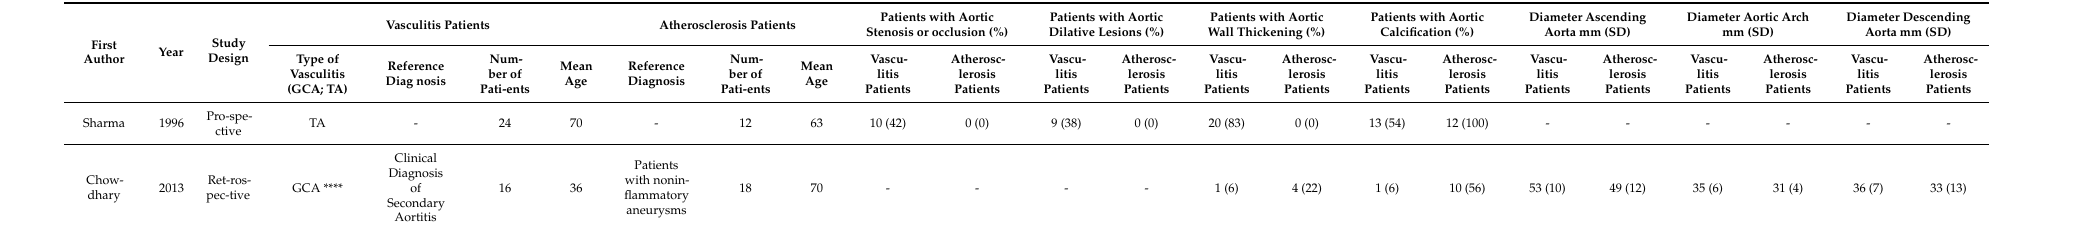
Table 4. Overview Outcome Parameters CT(A)